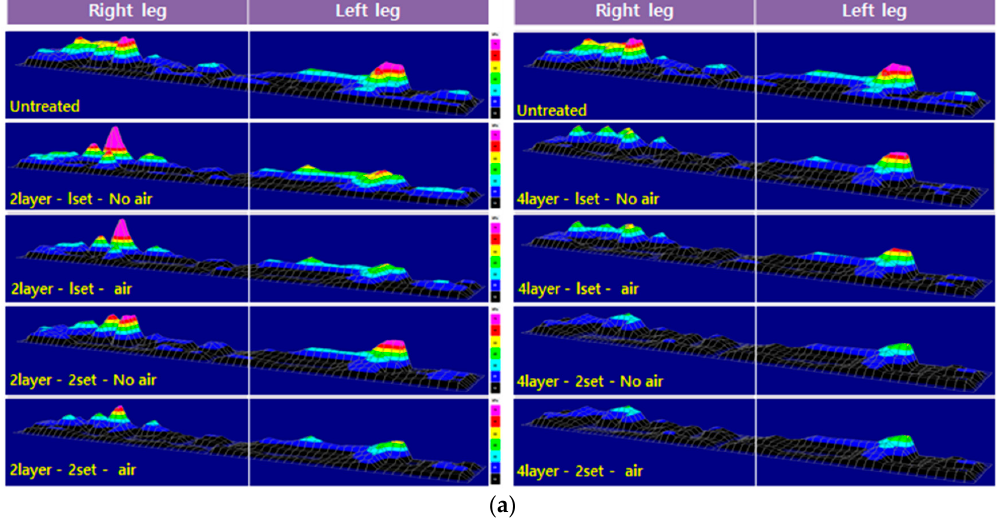
( c ) Figure 11. Pressure measurement results on the leg during loaded posture: ( a ) pressure distribution, ( b ) mean pressure, and ( c ) peak pressure. When the number of air pocket sets and layers was increased, the peak pressure decreased, as shown in Figure 11c. For the two-layered single-set harness, the peak pressures were 214 kPa and 178 kPa without and with air-charged air pockets, respectively. For the two-layered double-set harness, the peak pressures decreased to 160 kPa and 129 kPa without and with air-charged air pockets, respectively. In addition, for the four-layered single-set harness, the peak pressures were 134 kPa and 126 kPa without and with air-charged air pockets, respectively. The results for mean pressure followed a trend similar to peak pressure. 4. Discussion In this study, we developed a novel pant-type harness with a fabric air pocket to decrease the user pain caused by gravity. To validate the reduction in pain, we performed pressure measurement experiments using the developed harness, pressure sensor, and human mannequin. The results show that the pressure applied near the groin of the human mannequin decreased because of the increased contact area near the waist (achieved by multi-layered air pockets). In addition, the results show the relationship between pressure on the waist and leg at the loaded posture. Using the developed harness, the peak and mean pressures on the leg were reduced to 90 kPa and 10 kPa, respectively. From the results of our study, when the peak pressure on the waist increased, the peak pressure on the leg decreased. Figure 12a shows the relationship between peak pressures on the waist and leg, while Figure 12b shows the relationship between mean pressures on the waist and leg.